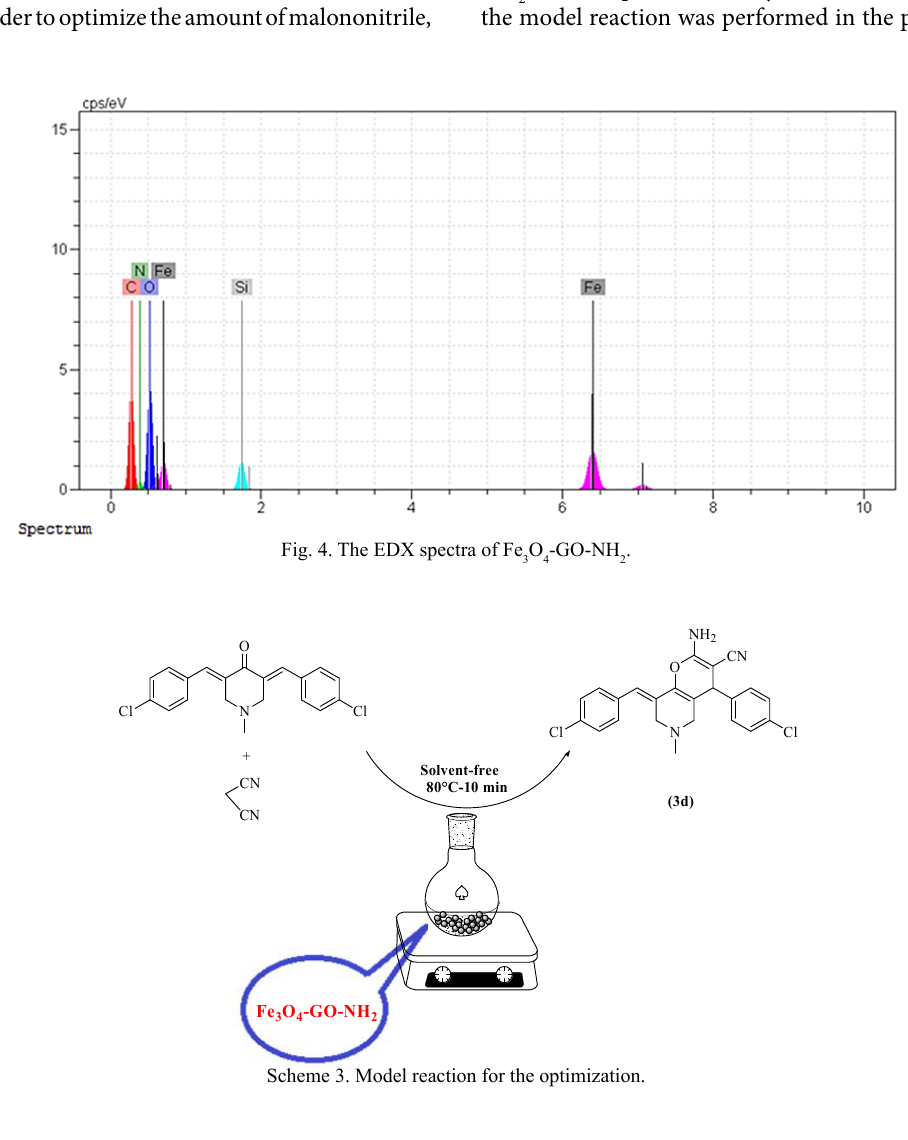
Scheme 3. Model reaction for the optimization.